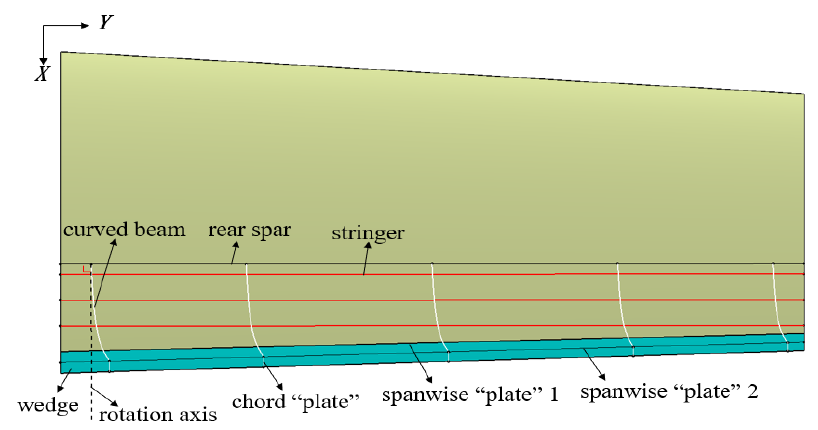
Figure 3. The original method applied to the non-equal chord wing.